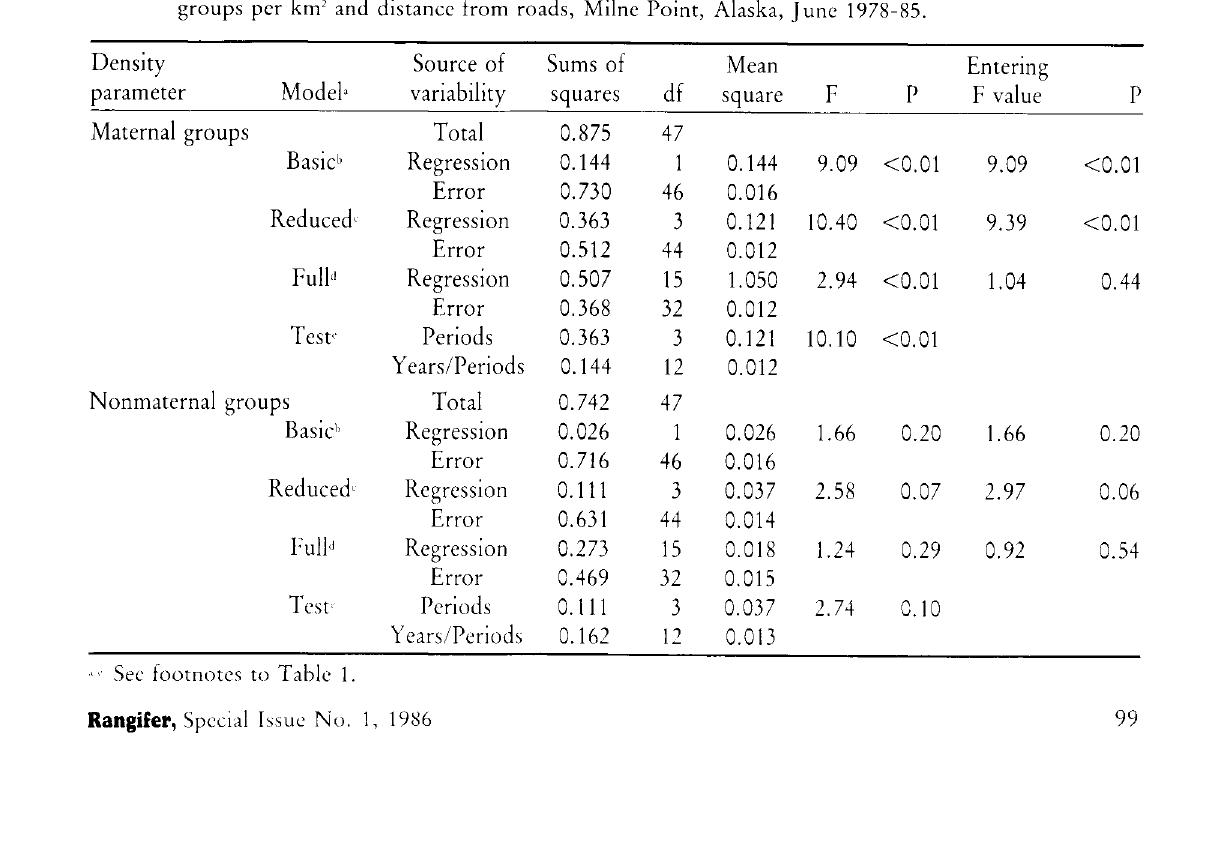
Table 2. Analysis of variance examination of the relationships between numbers of maternal and nonmaternal groups per km 2 and distance from roads, Milne Point, Alaska, June